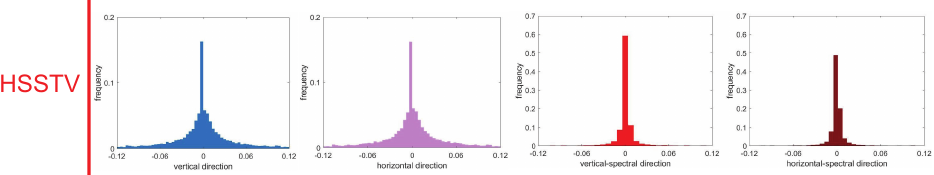
Figure 3. The sparsity comparison of ASSTV, SSTV and